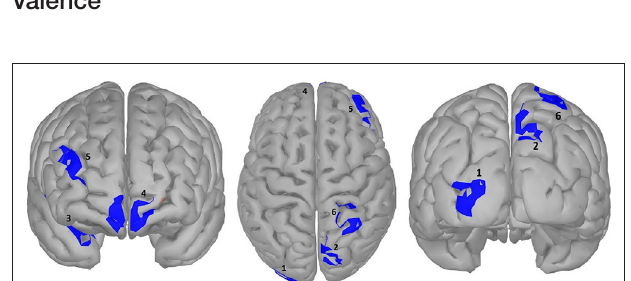
FIGURE 8 | significance map for